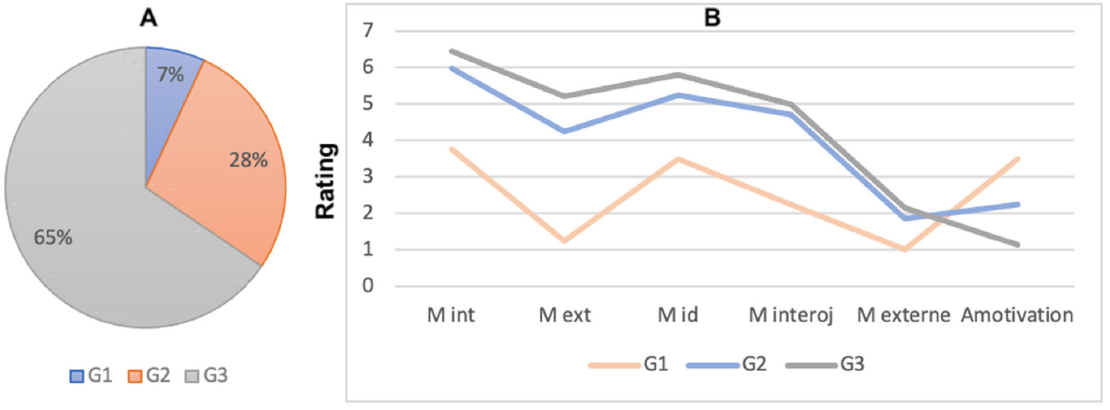
Figure 7. ( A ) Distribution of participants according to WES scores (G1: Low motivation; G2: Moderate motivation; G3: High motivation). ( B ) Graphical representation of average motivation scores by cluster for a four ‐ cluster solution.